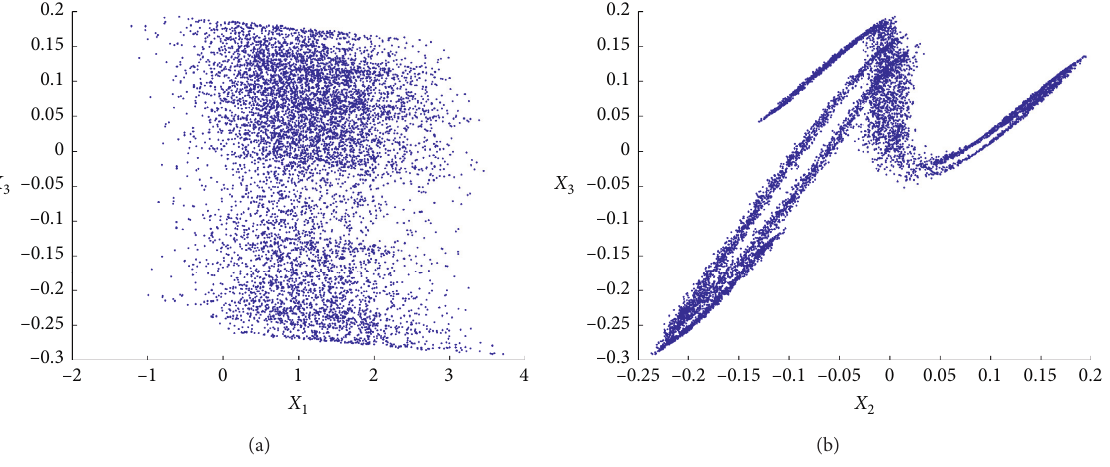
Figure 2: Poincar´e sections of x